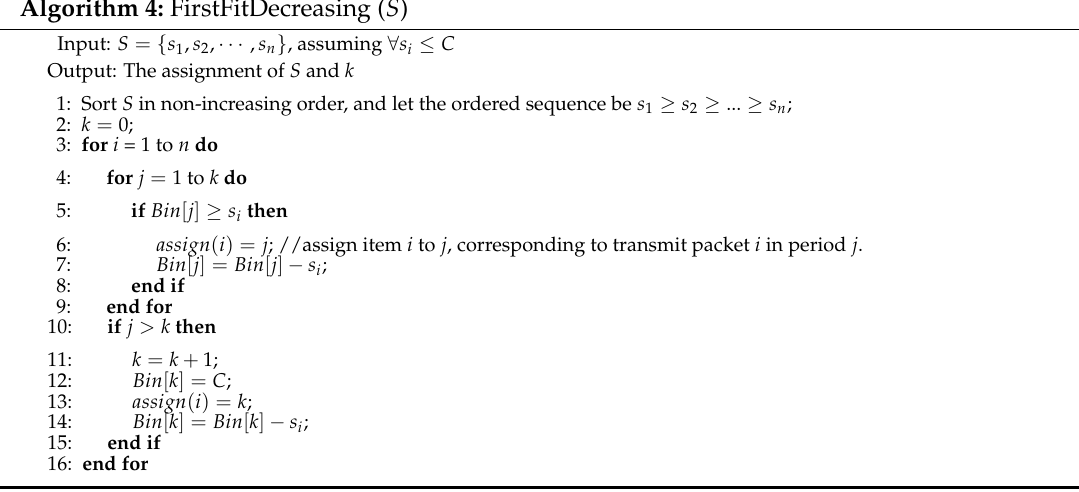
Algorithm 4: FirstFitDecreasing ( S